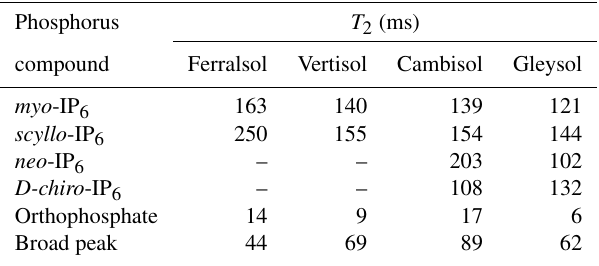
Table 6. Transversal relaxation times ( T 2 ) of various P species in the orthophosphate and phosphomonoester regions as determined by solution 31 P nuclear magnetic resonance (NMR) spectroscopy and a Carr–Purcell–Meiboom–Gill (CPMG) pulse sequence on hy- pobromite oxidised soil